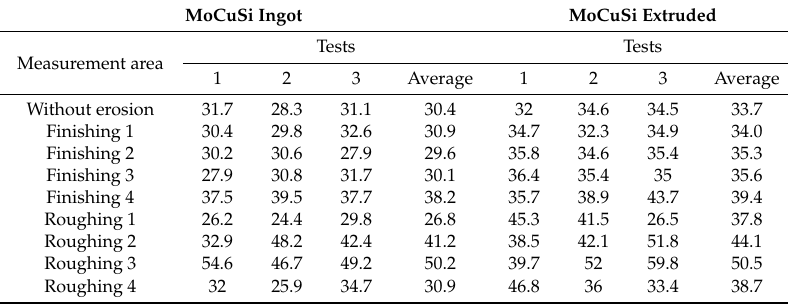
Table 10. Hardness with MoCuSi ingot/extruded